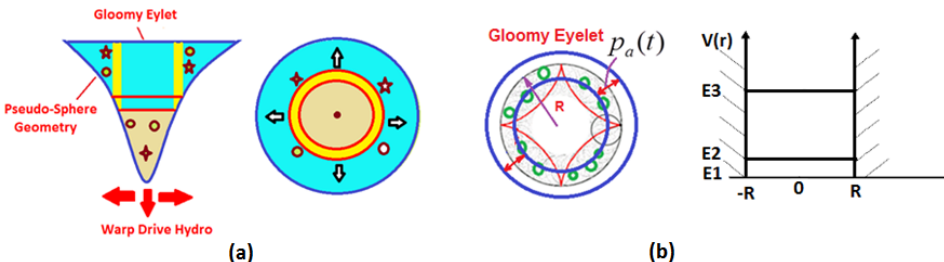
Figure 4. ( a ) Generation of gloomy eyelet and warp drive model on the pseudo-sphere geometry of pressure drop of Rankine model; ( b ) potential energy field for the gloomy eyelet inside the border line of gloomy eyelet on the standing wave of rotating mode shape.